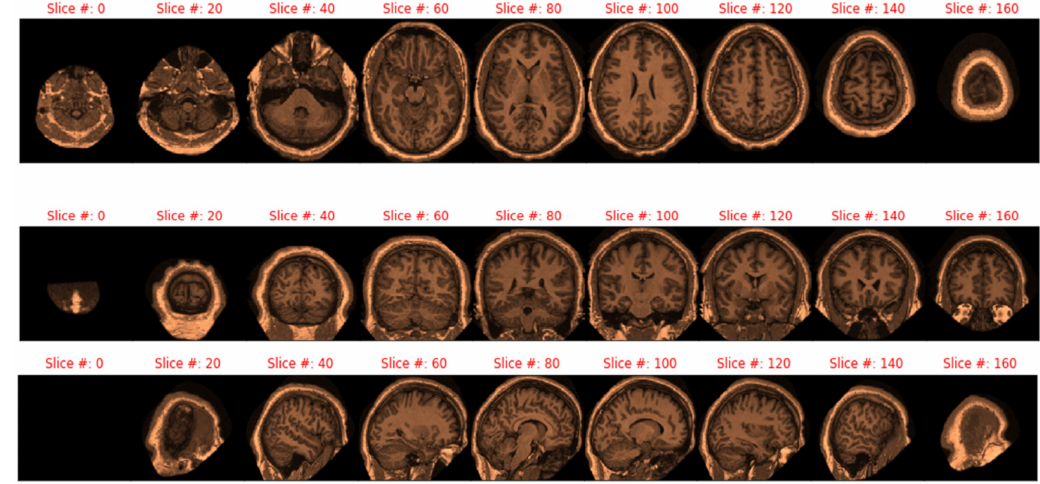
Figure 6. Eigenbrain imagery associated with Figure